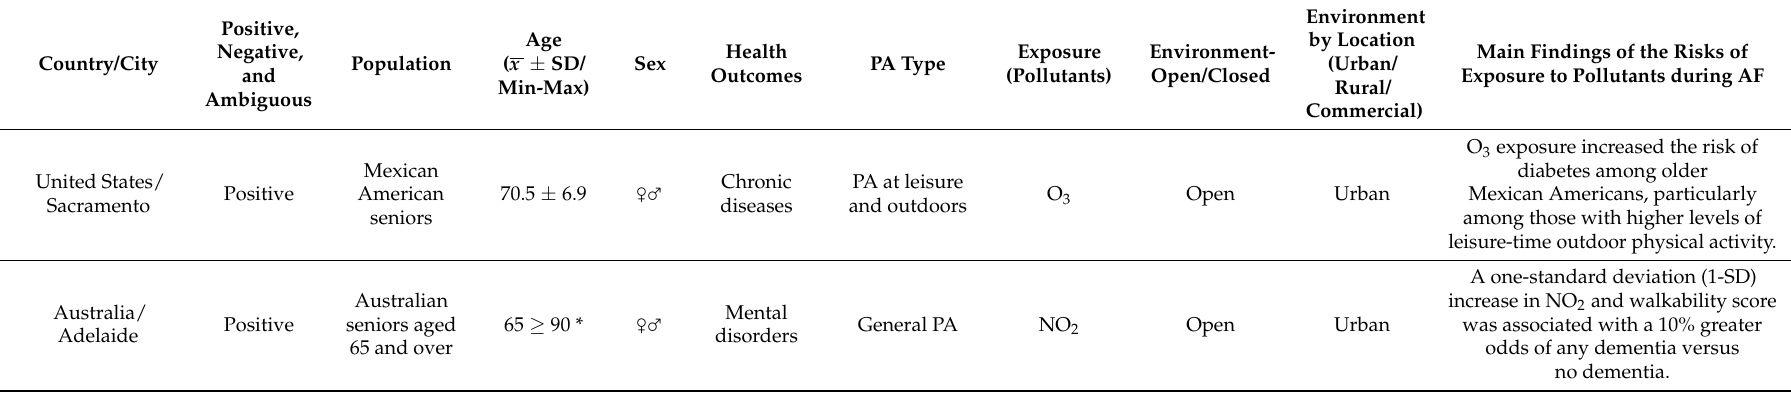
Table 5. Sample characteristics (sex and age), pollutants, physical activity, health outcomes, and findings on the risks of pollutants on the health of older adults during